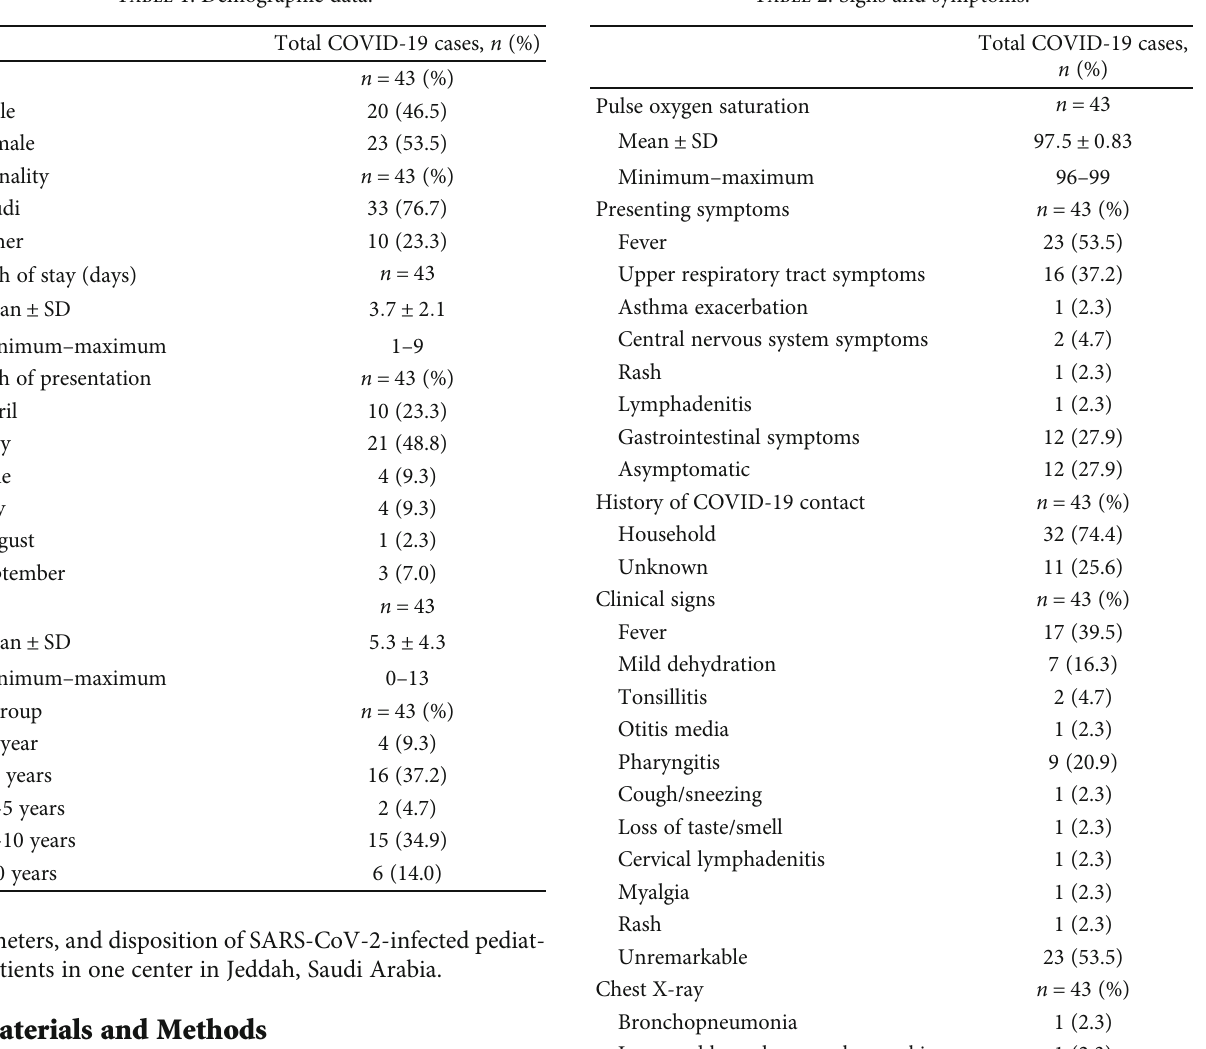
Table 1: Demographic data. Table 2: Signs and